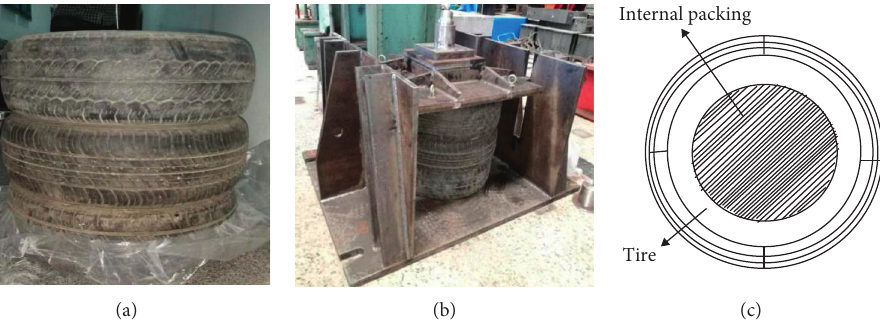
Figure 7: The final composite